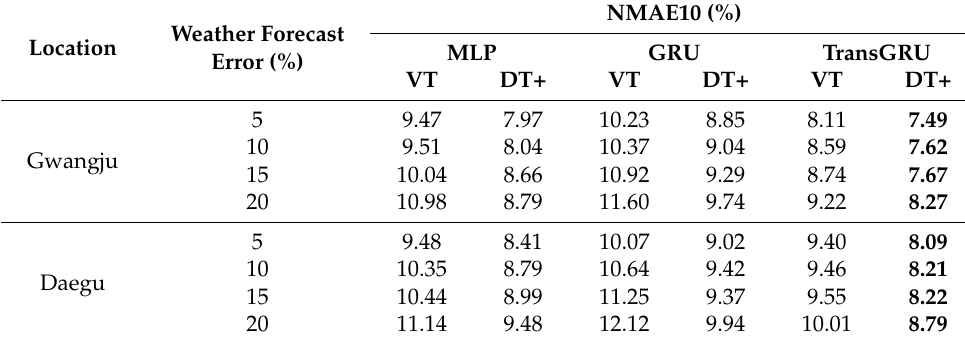
Table 4. PV forecasting error of individual PV sites.